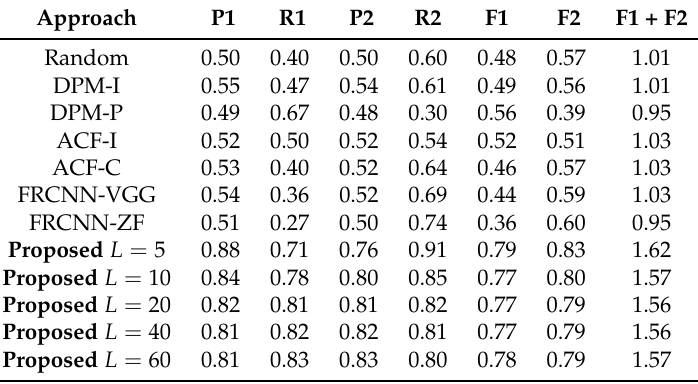
Table 2. Absence/presence of people classification results obtained by a random classifier, by the six detectors independently and using our proposal with different number of thresholds L = { 5,10,20,40,60 } .